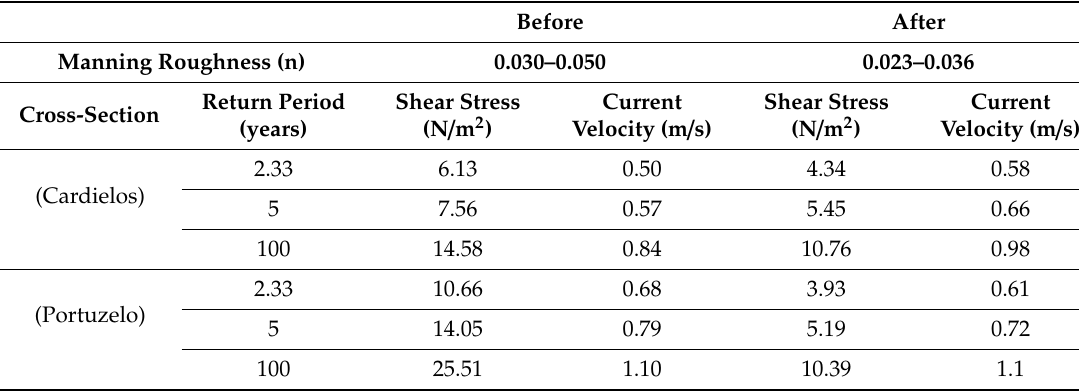
Table 3. Values obtained by simulation with the HEC-RAS model to compare hydraulic parameters before and after the